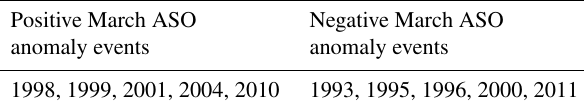
Table 2. Selected positive and negative years for March ASO anomaly events based on SWOOSH data for the period 1984–2016. Positive and negative March ASO anomaly events are defined us- ing a normalized time series of March ASO variations from 1984 to 2016. Values larger than 1 standard deviation are defined as positive March ASO anomaly events, and those below − 1 standard devia- tion are defined as negative March ASO anomaly